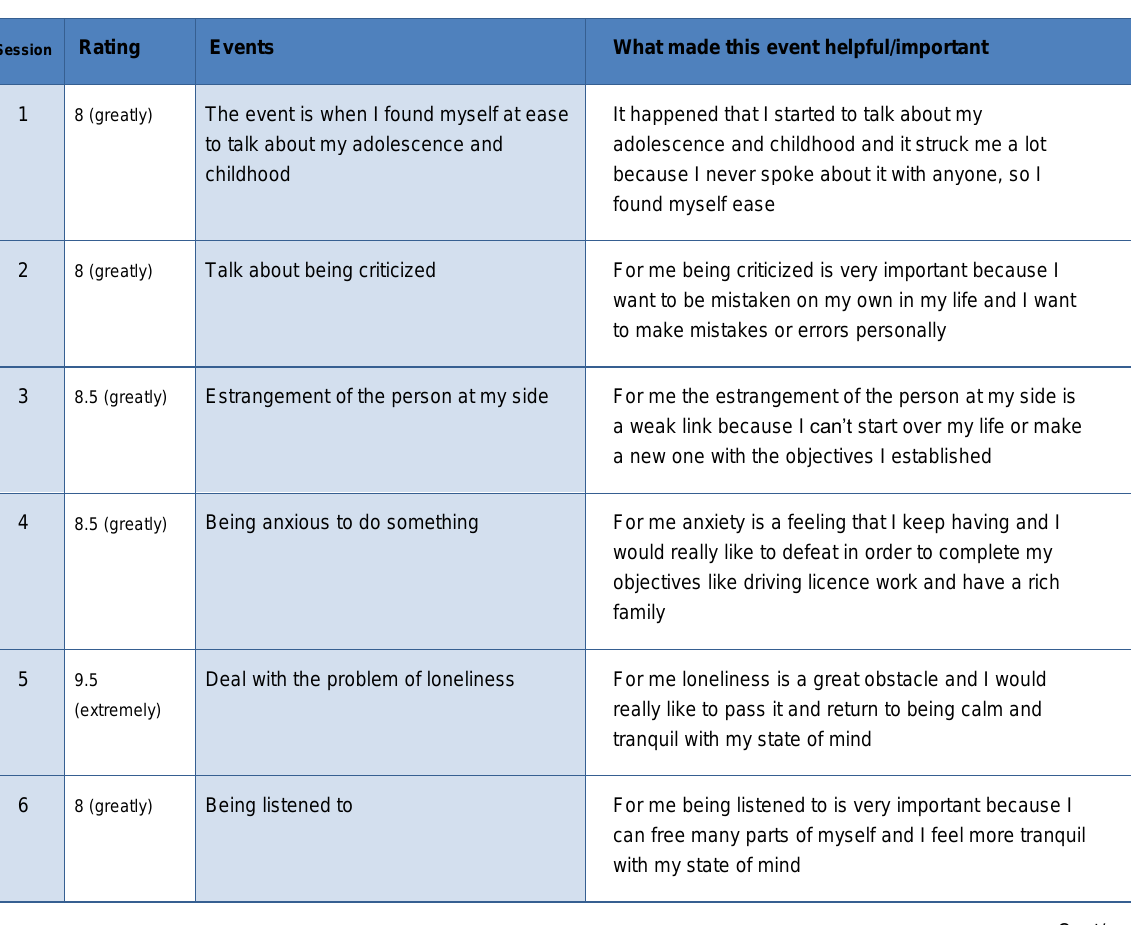
Table 2: Giorgio’s personal problems (PQ), duration and scores